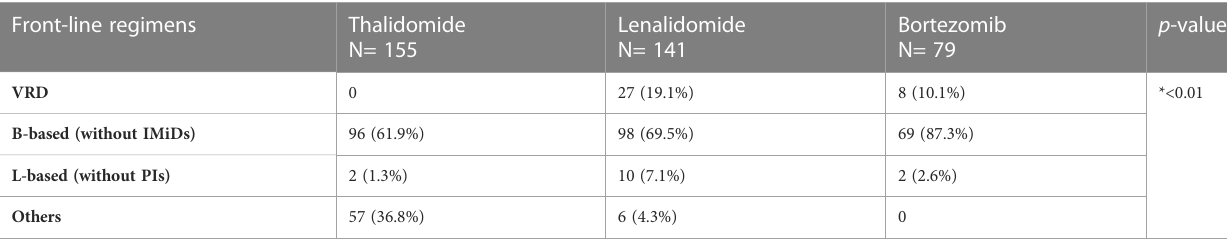
TABLE 2 Front-line regimens in patients with different maintenance treatment. Front-line regimens